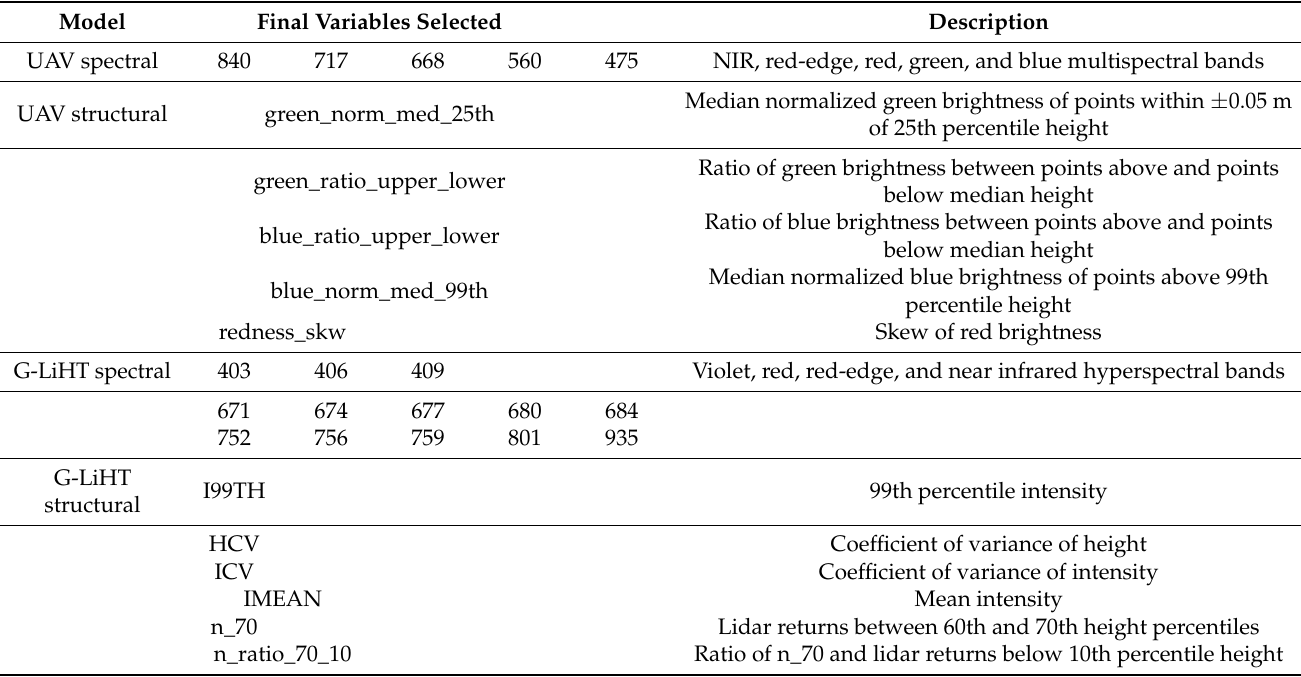
Figure 4. The five color-coded shaded rectangles show MicaSense sensor bands (blue = 459–491, green = 546.5–573.5, red = 661–675, red-edge = 711–723, NIR = 813.5–870.5) with a color-coded horizontal bar in each representing the normalized F-ratio. Gray vertical bars on x -axis show the frequency (out of 100 model runs) that each G-LiHT spectral band was selected by RF model. Dark grey bars with text labels highlight the final selected G-LiHT bands. Dashed black line shows normalized G-LiHT F-ratios. Dark green, green, and red lines are normalized mean G-LiHT spectrum per non-infested, green, and dead health statuses, respectively. Table 5. Final variable selection for spectral and structural classification